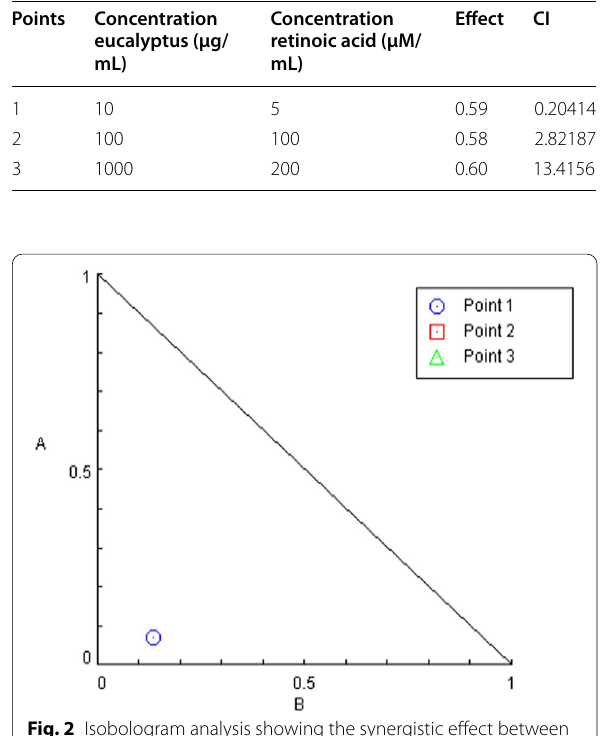
Fig. 2 Isobologram analysis showing the synergistic effect between EU and RA in the lowest concentration on SK‑GT‑4 cell line, after 72 h of treatment (Regarding points 1, 2, 3 note Table